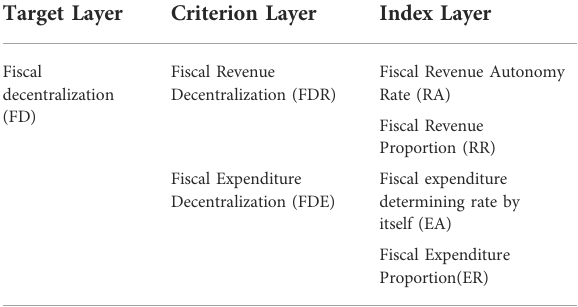
TABLE 2 Fiscal decentralization index system